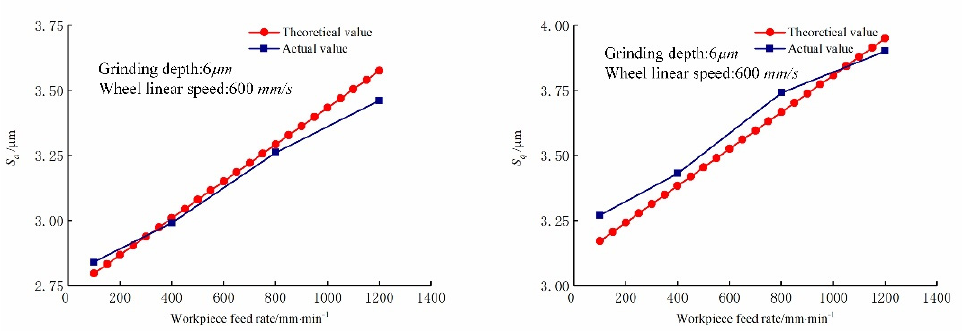
Figure 10. Effect of feed rate on the three-dimensional surface roughness. (Grinding depths: 6 µ m,